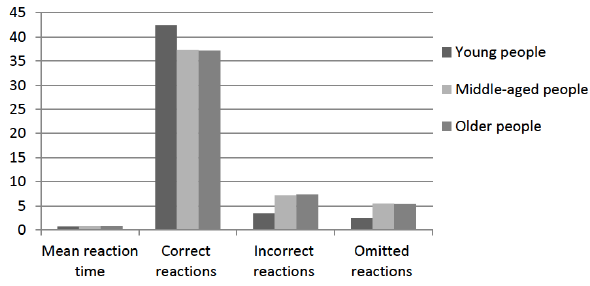
Figure 3: Mean reaction times, correct, incorrect and omitted re- actions as measured by the visual-motor coordination test (AK) in three age groups, N = 95.